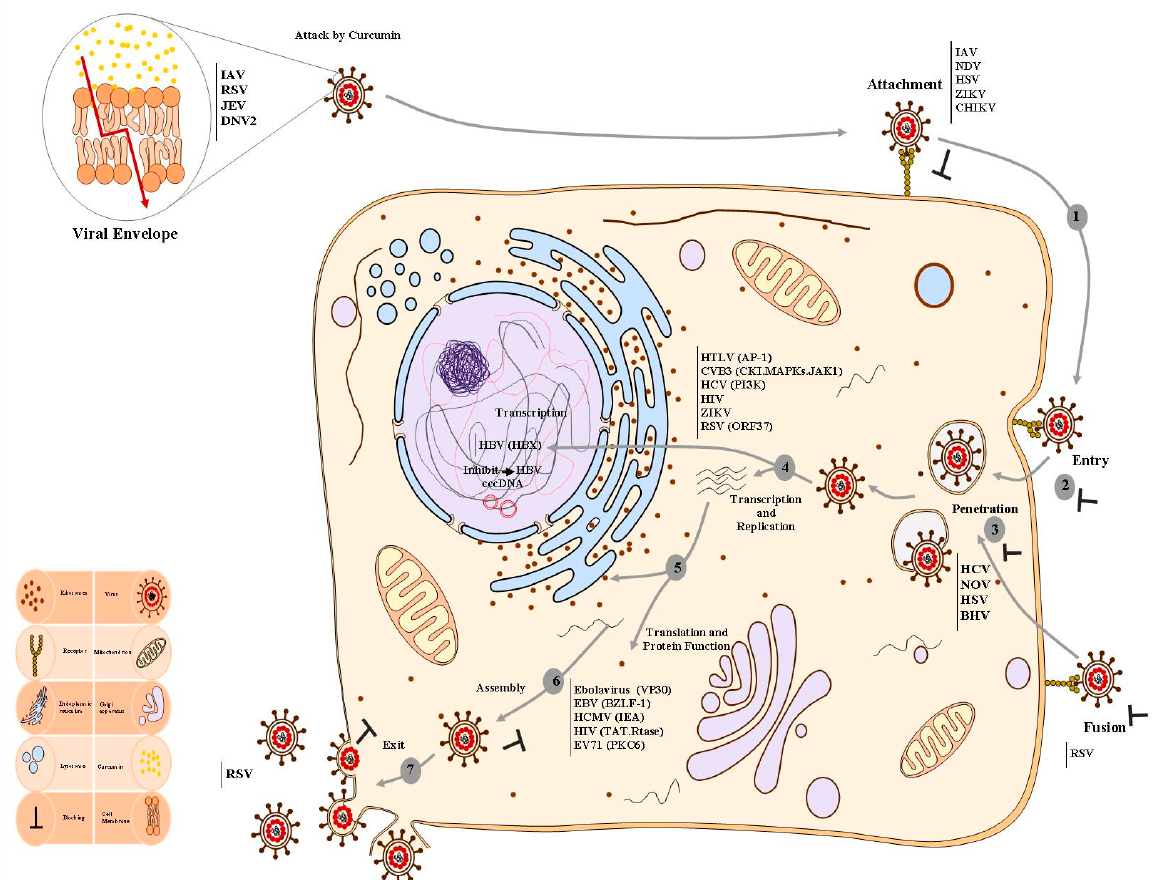
Figure 2. The effects of curcumin on different viruses and multi-site inhibitory effects of curcumin in the life cycle of human viruses. In general, the virus life cycle can be divided into various stages including: ( 1 ) attachment of virion, ( 2 ) entry, ( 3 ) viral genome replication, ( 4 ) viral transcription, ( 5 ) viral translation, and ( 6 ) virion assembly and exit. Hence,